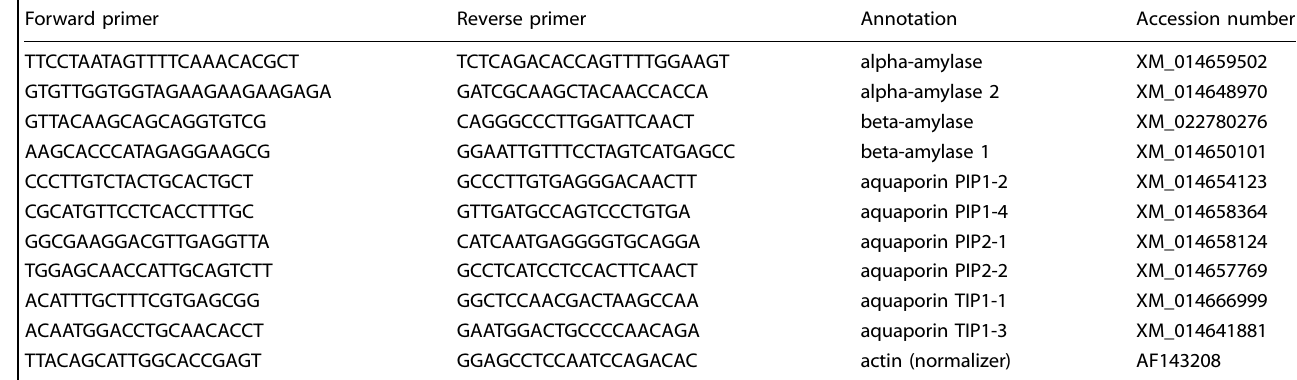
Table 4. Real-time PCR primer sequences. Forward